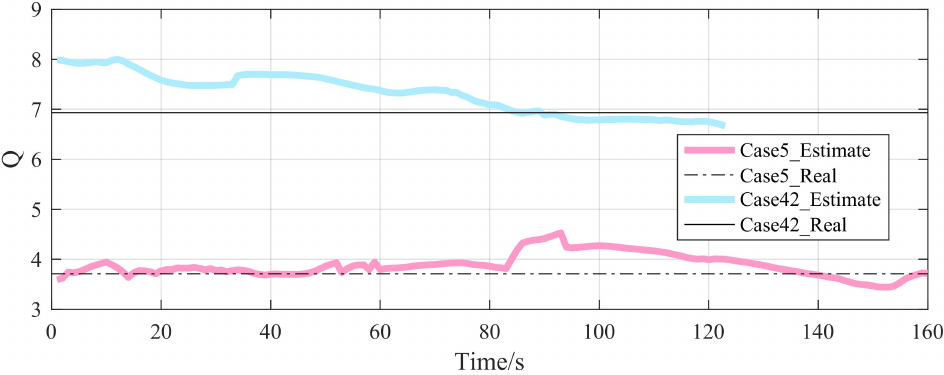
Figure 13. Q-value comparison between Case 5 and 42, as shown in Figure 12. An accurate Q estimation at the beginning of an episode and maintains accuracy throughout the processes in both case 5 and case